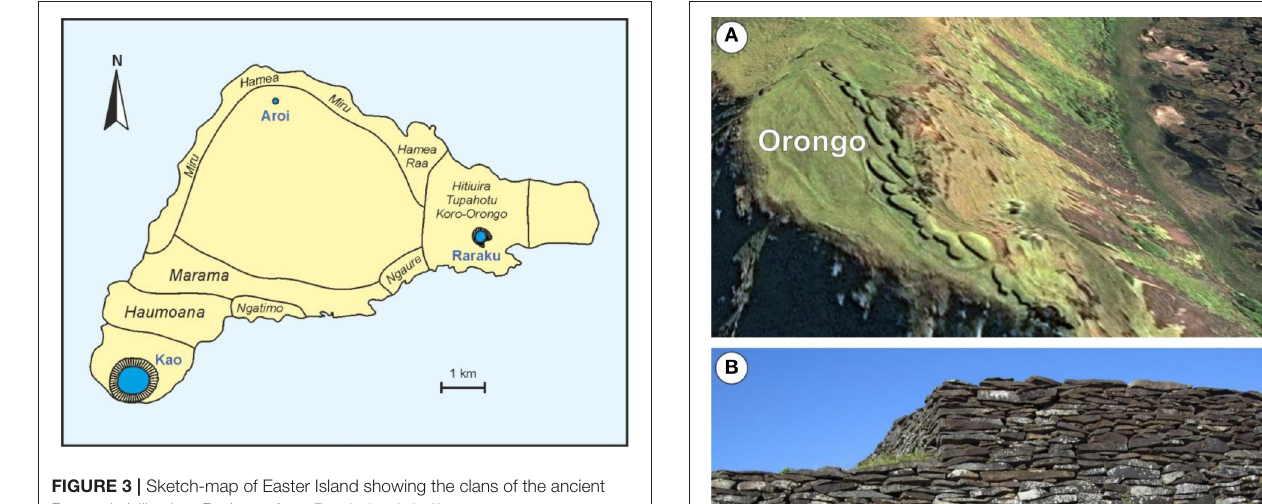
moai quarry, to Rano Kao, the headquarters of the BC (Kirch, 2000).